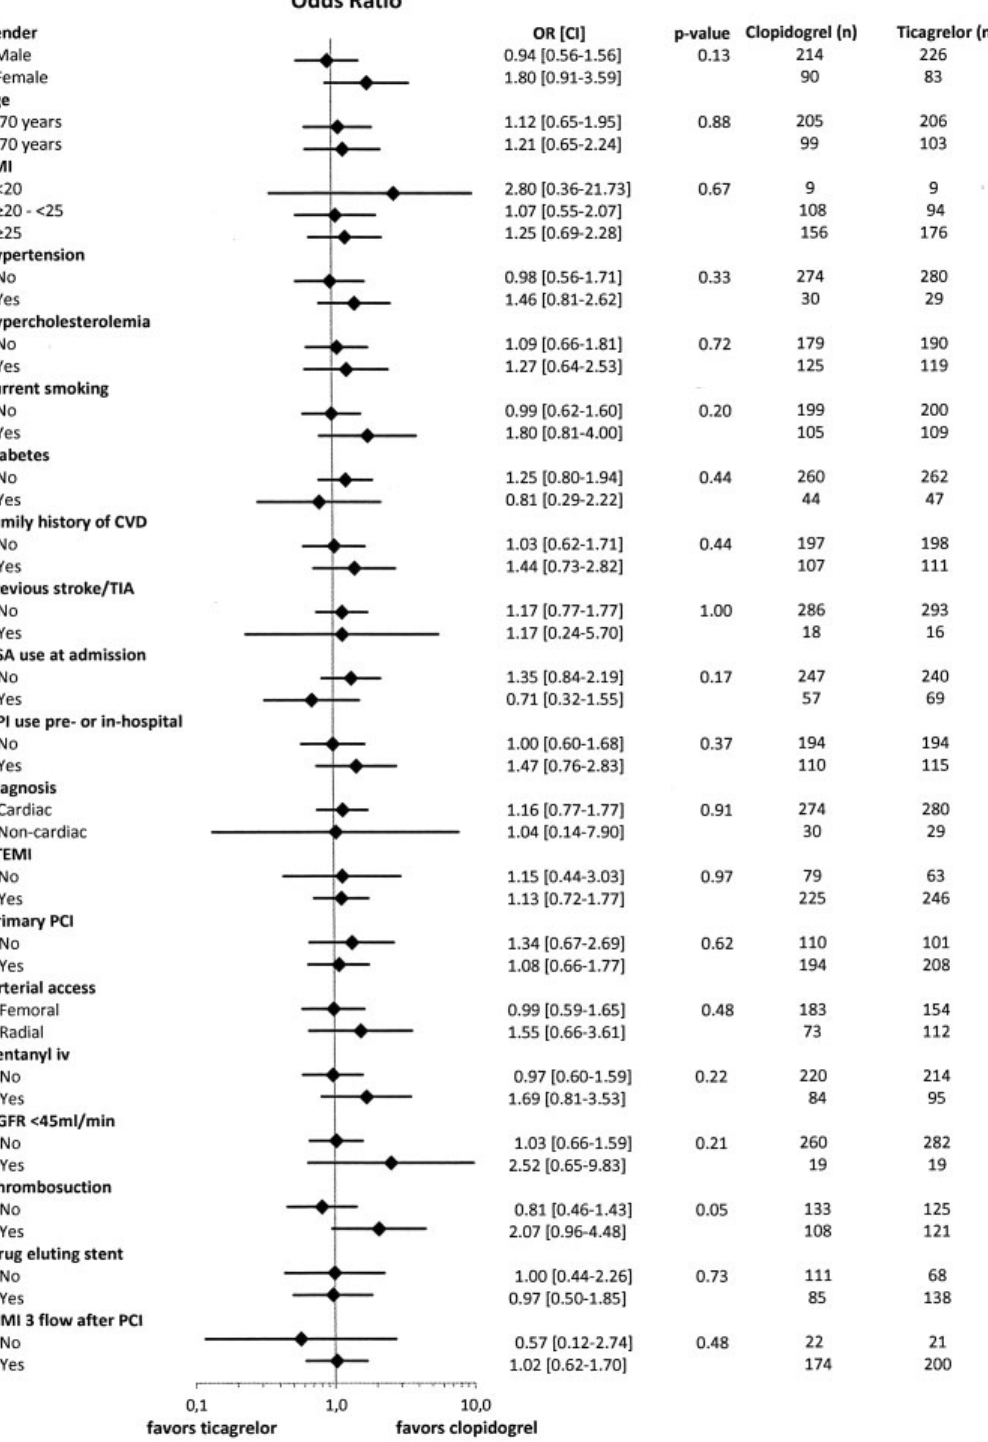
Fig. 2 Subgroup analysis for interaction. p -Value is the value for interaction. ASA, acetylsalicylic acid; BMI, body mass index; CI, con fi dence interval; CVD, cardiovascular disease; DES, drug-eluting stent; eGFR, estimated glomerular fi ltration rate; GPI, glycoprotein GPIIb/IIIa inhibitor; n , number; OR, odds ratio; PCI, percutaneous coronary intervention; STEMI, ST-segment elevation myocardial infarction; TIA, transient ischemic attack; TIMI, thrombolysis in myocardial